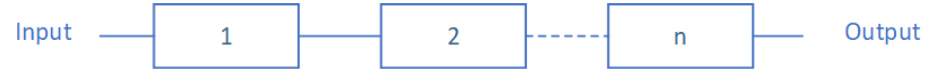
Figure 2. A series structure architecture according to the Reliability Block Diagram (RBD)